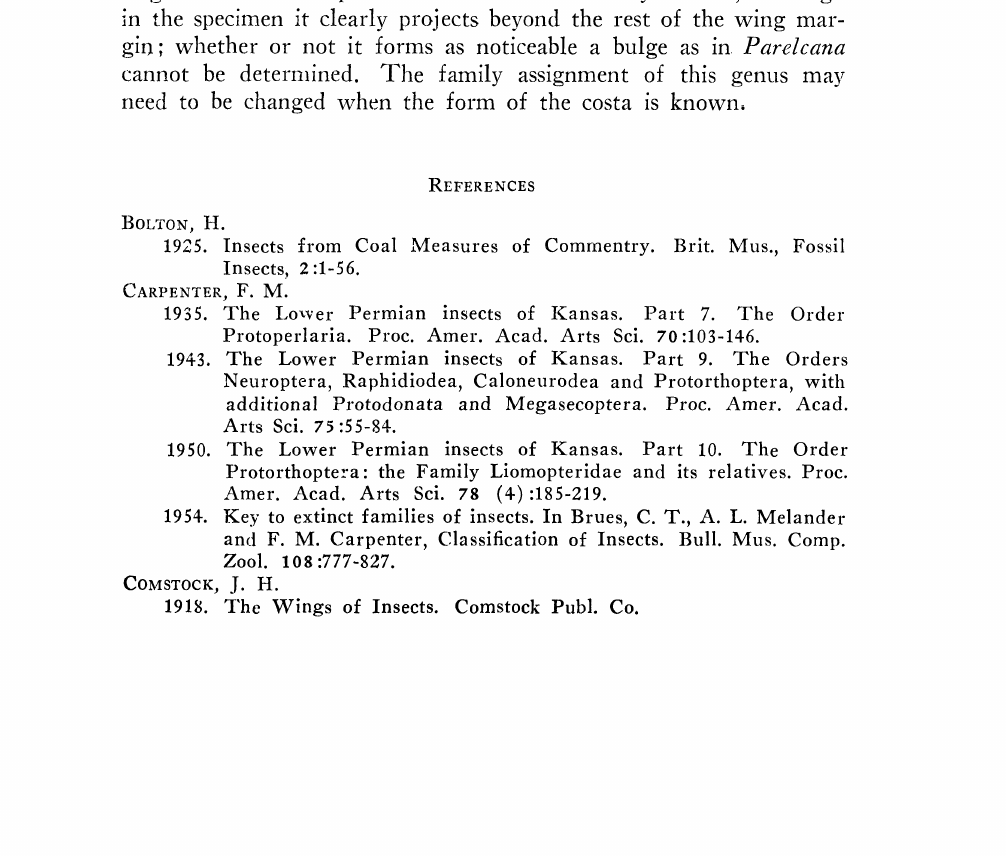
Text-figure 20. Petrelcana elongata, n. sp. Drawing of fore wing (holo- type). most of costal area; cross veins, between R and Rs sigmoidal